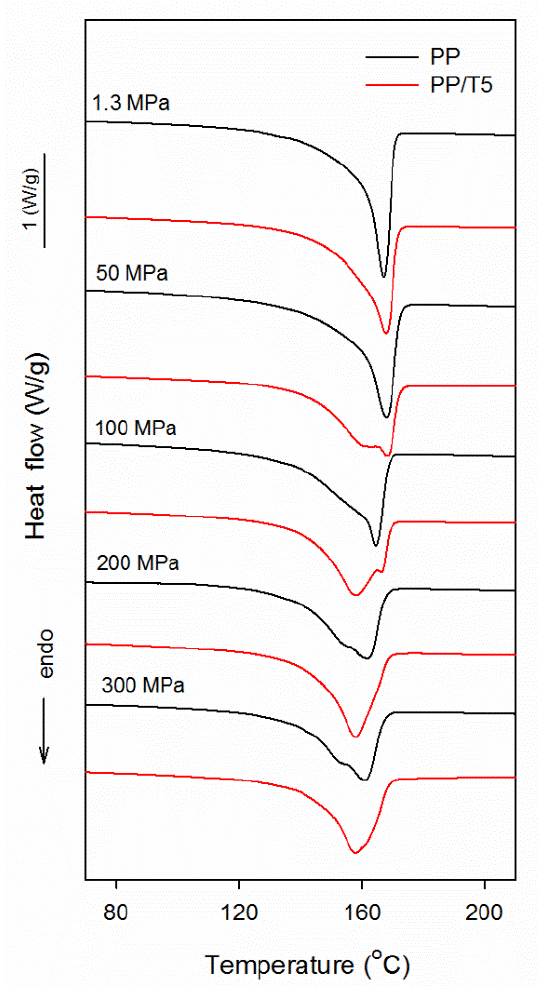
Figure 8. DSC heating thermograms of neat PP and PP/T5 nanocomposites crystallized during cooling under various pressures, recorded at 10 °C/min.